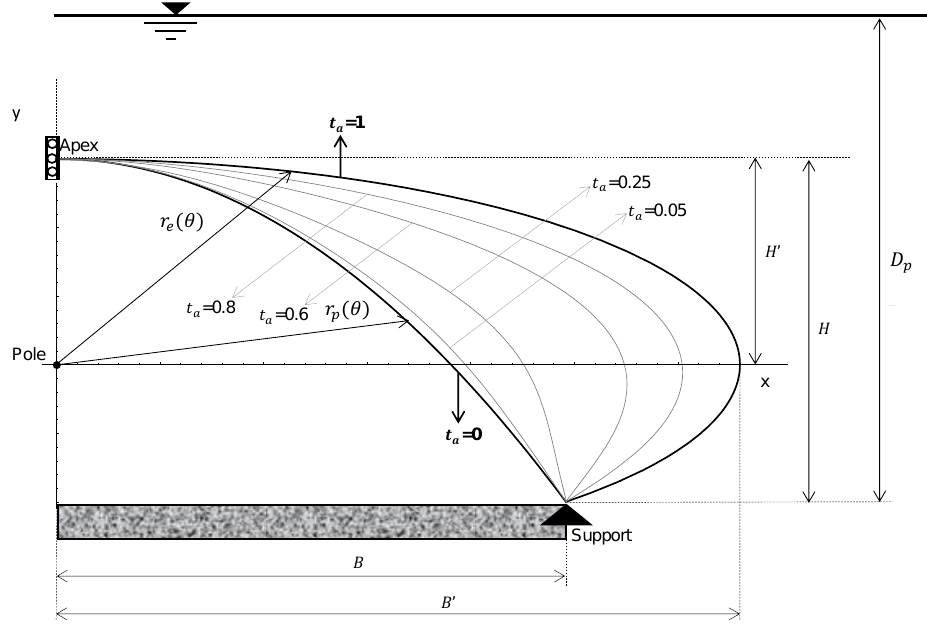
Figure 2. Schematic example of the parametric curve